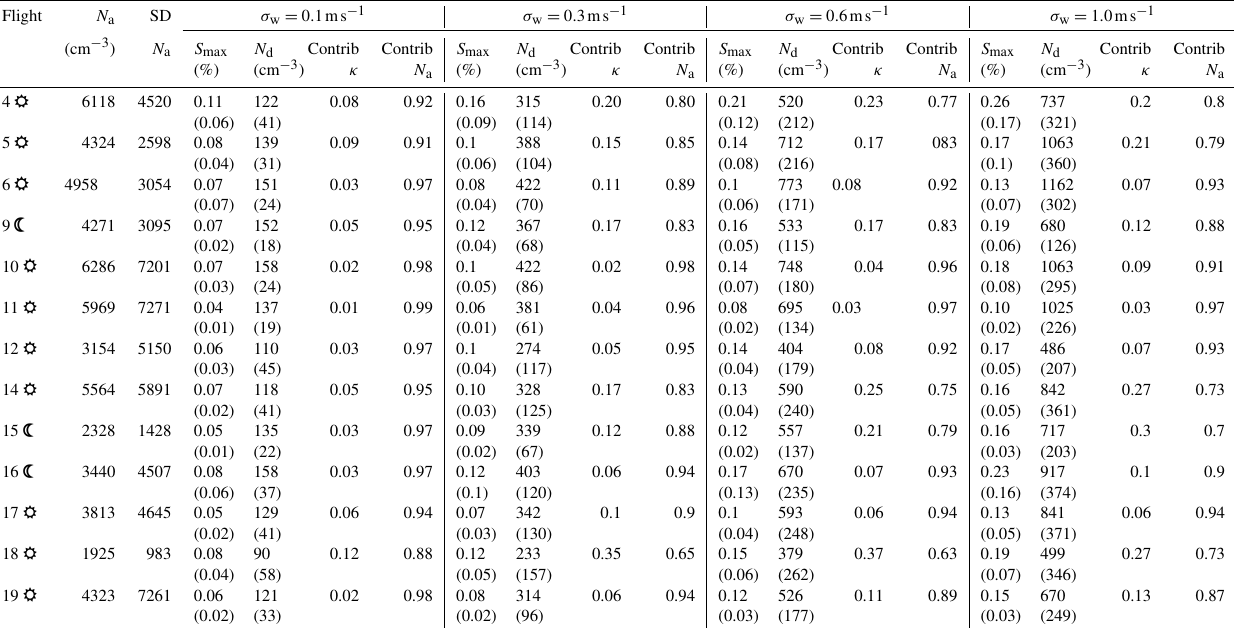
Table 3. Derived cloud parameters (maximum supersaturation, droplet number) and relative contribution (Eq. 2) of chemical composition and total aerosol number for different vertical velocities. Numbers in parentheses indicate standard deviation values. The symbol “ ” next to each flight number refers to a daytime flight, and “ ” refers to a nighttime